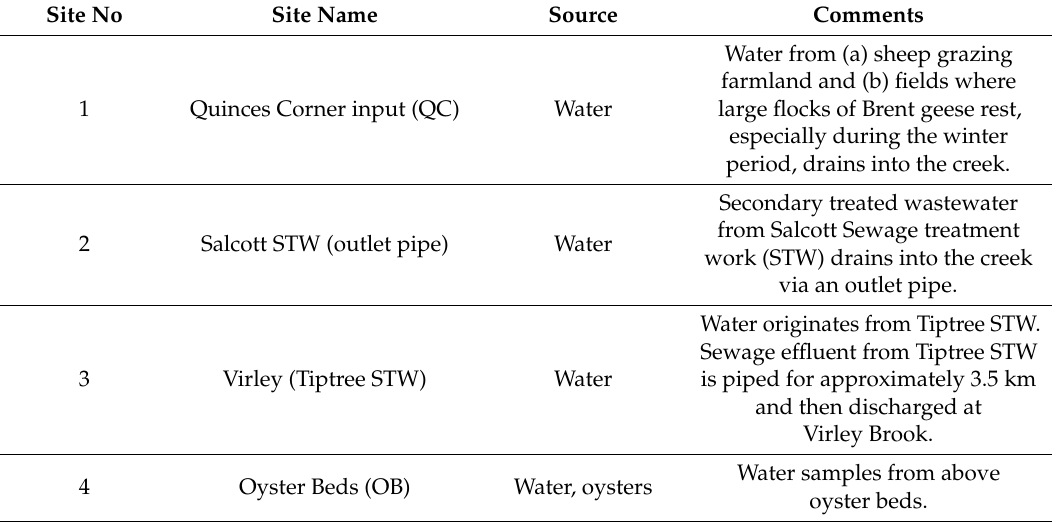
Table 1. The di ff erent sampling sites used in the sterol